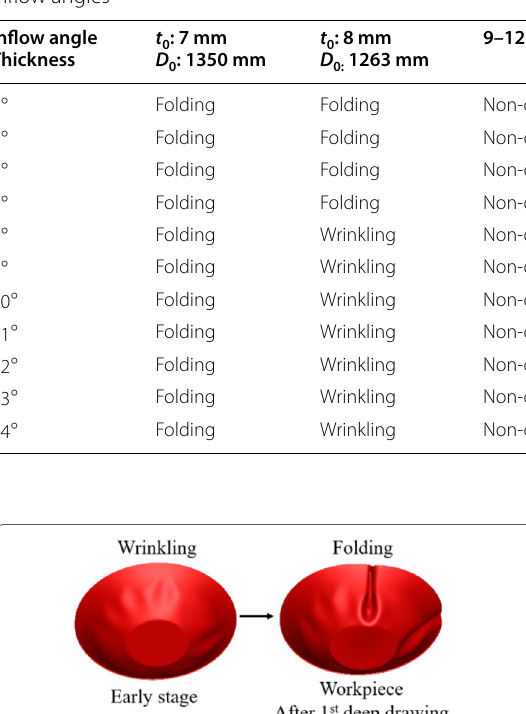
Table 5 Forming defects according to blank thickness and the inflow angles